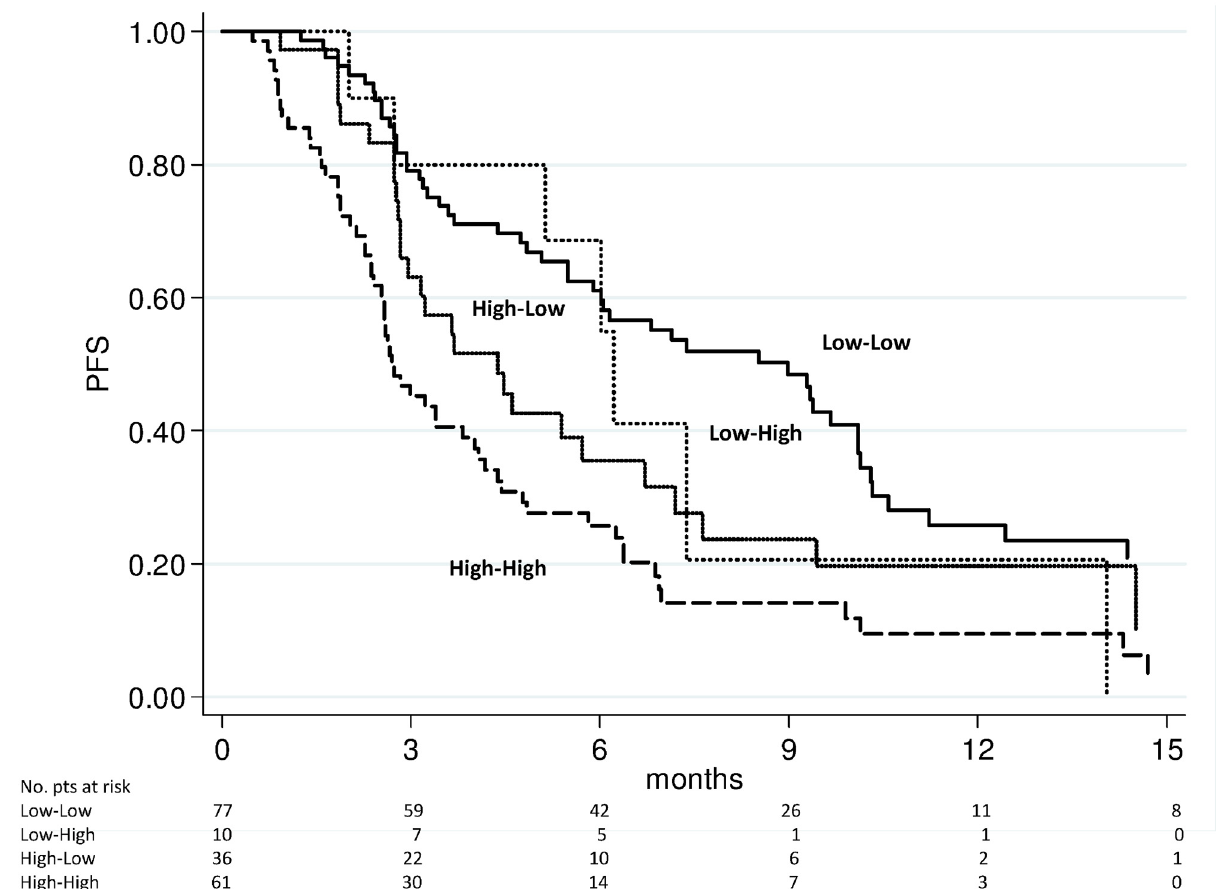
Fig 3. Progression-free survival according to pre-therapy and follow-up NLR at 4 weeks of enzalutamide